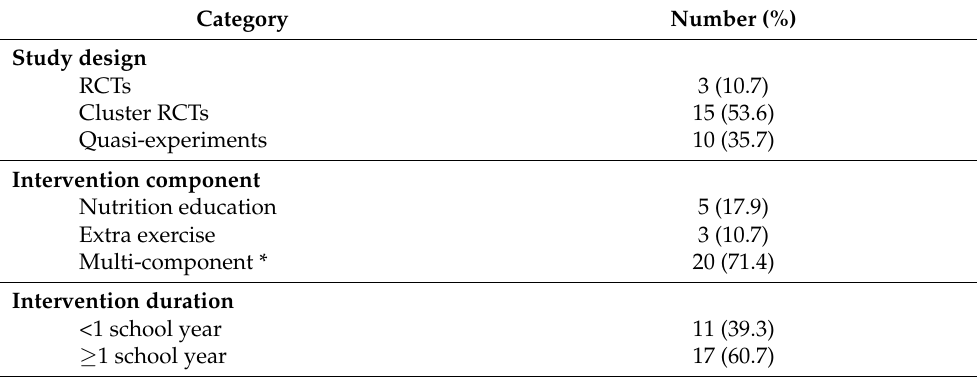
Figure 1. PRISMA diagram of the review process. Table 1. Summary of the studies included in this